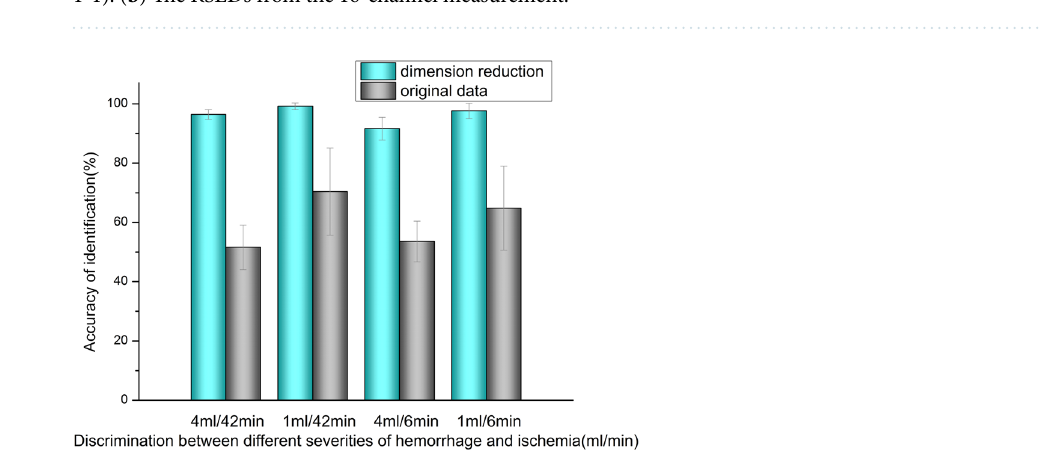
Figure 5. Comparison of the accuracy of stroke type recognition before and after dimensionality